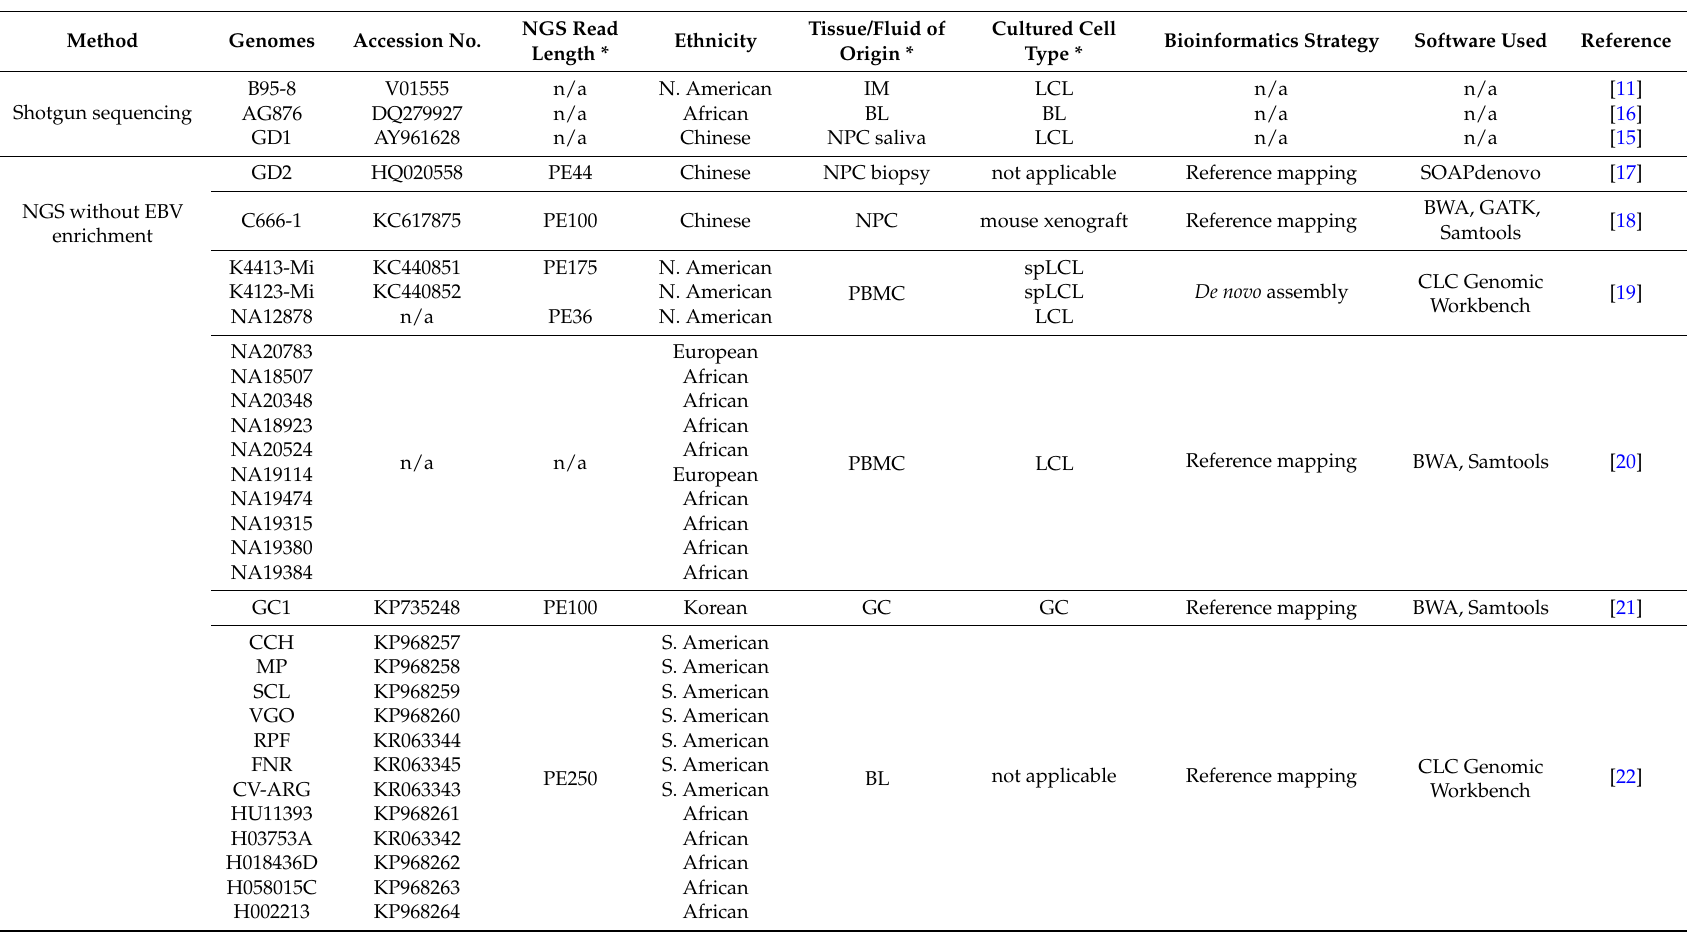
Table 1. Summary of sequencing methods of published EBV